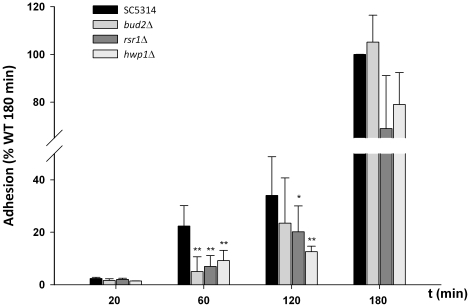
Adhesion kinetics of C. albicans wild type (WT),
bud2Δ, rsr1Δ and
hwp1Δ mutant cells.Oral TR146 epithelial cells were co-incubated with 105
C. albicans cells for either 20, 60, 120, or 180 min.
After extensive washing and fixation, the samples were stained and the
adherent cells were counted under the fluorescence microscope. The
experiment was performed at least three times in duplicates. The values
are calculated as percentage of adherent cells compared to wild type
adherent cells at 180 min (100%). */**, significant
difference compared to the adhesion of the corresponding WT to oral
epithelial cells
(p<0.05/p<0.01).